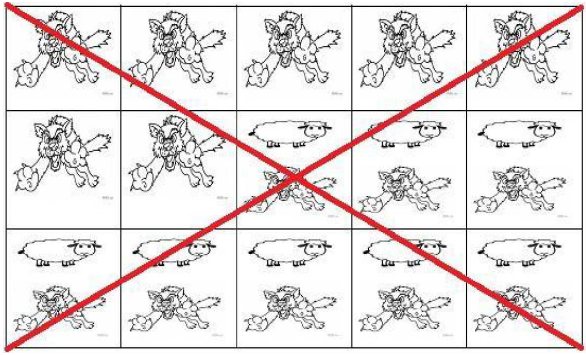
Fig. 2 Some patches have predators such as wolves.